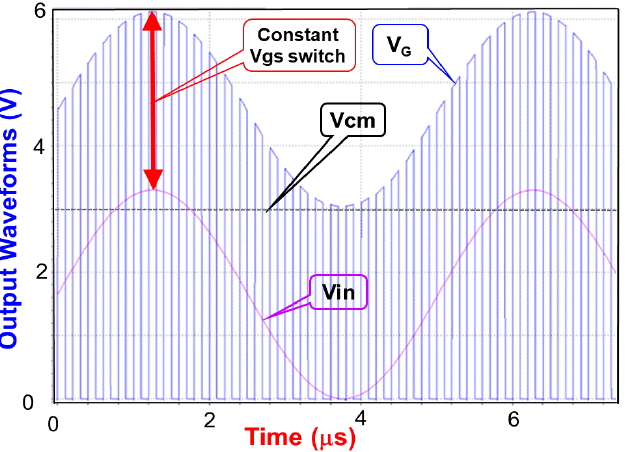
Figure 6. Simulated output waveforms of the modified bootstrapped switch with a constant V gs .